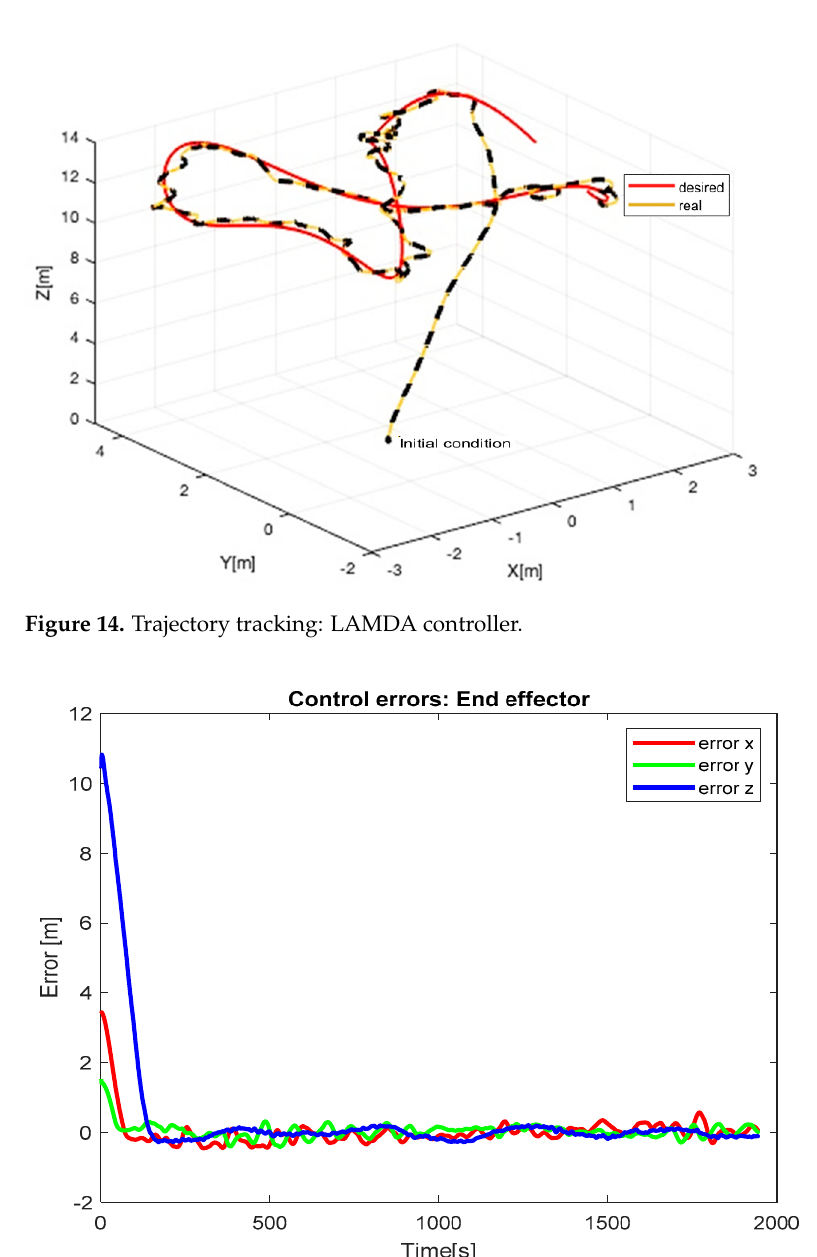
16 of 21 Figure 13. Control errors: SMC controller.